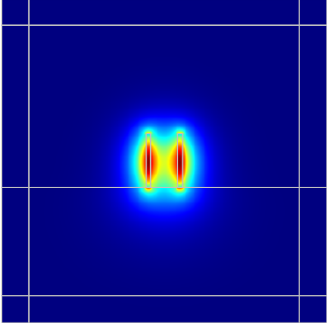
Fig. 5 Profile of the fundamental mode in a dual core waveguide in the case of 2  d env